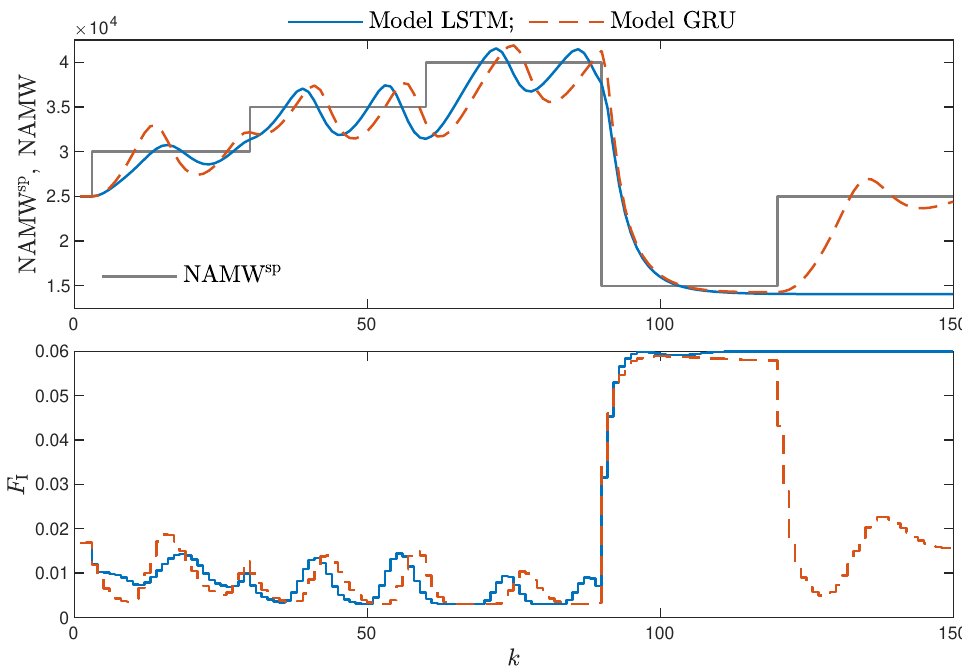
Figure 17. The polymerisation reactor: MPC results with the LSTM and GRU models for n N = 10, n A = n B = 1.